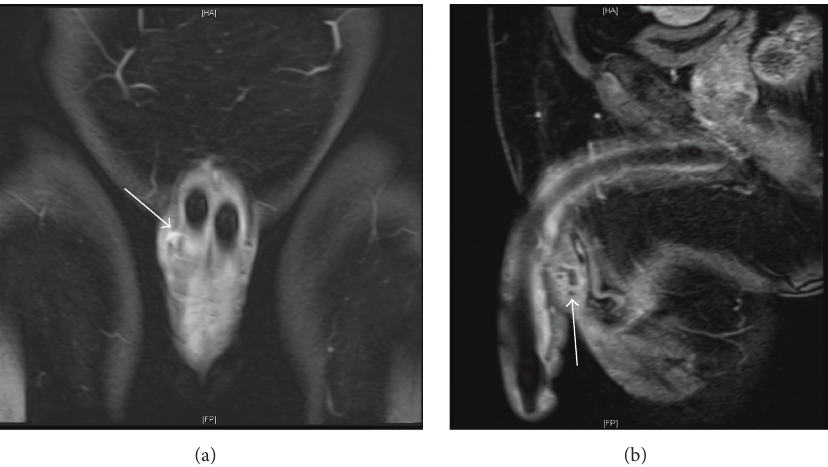
Figure 1: Coronal (a) and sagittal (b) MRI views of the collection revealing its multiloculated structure and communication with the right corporal body